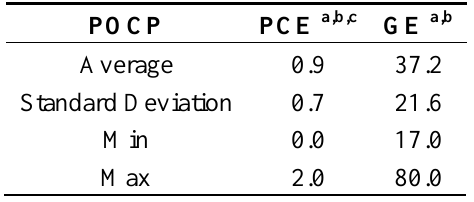
Table 3. Dimensionless photochemical ozone creation potential (POCP) for PCE and Glycol Ether (GE) compounds expressed relative to the reference compound,